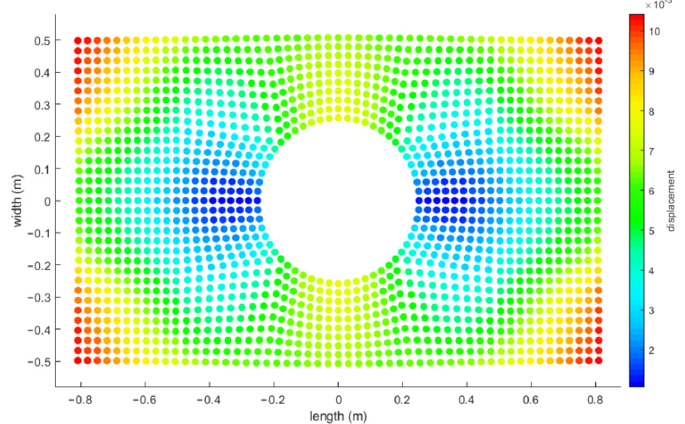
Figure 33. The displacement field of this perforated tension strip at t = 0.065 s.